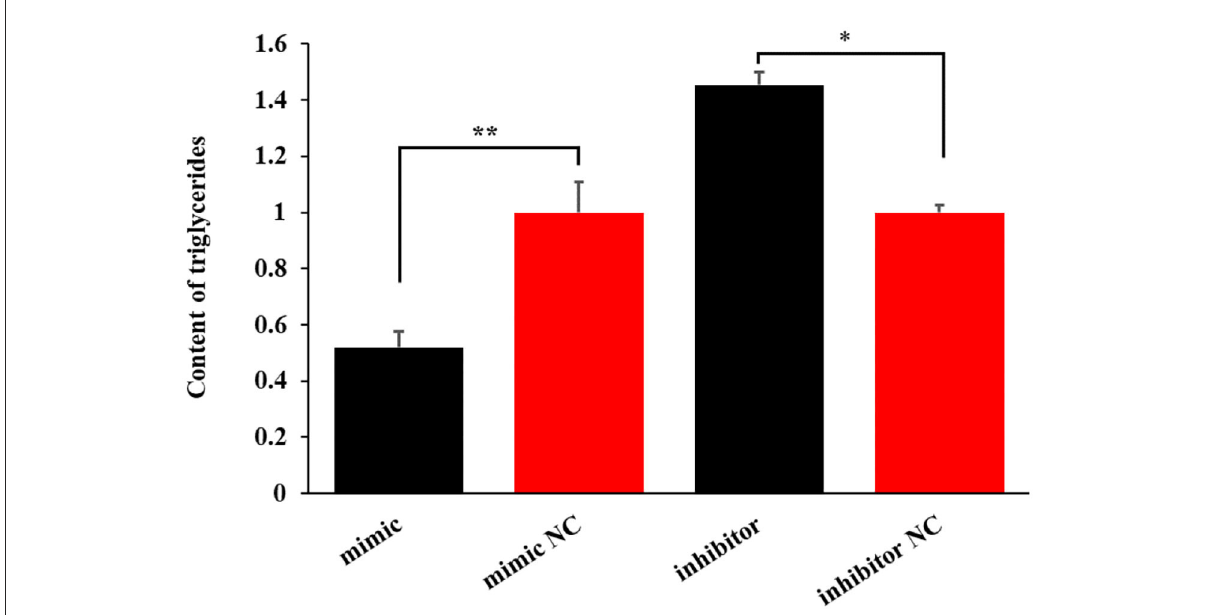
FIGURE4 The effect of miR-199a-3p on the content of triglycerides in ovine mammary epithelial cells (OMECs). ** P < 0.01 and * P <